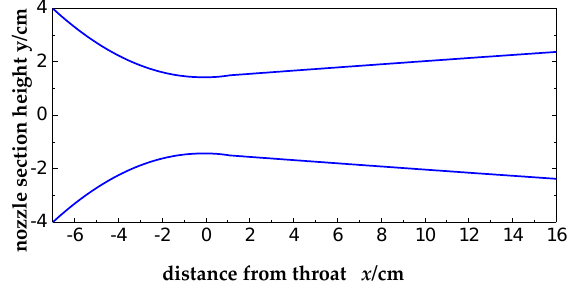
Figure 6. Geometric data of the de Laval nozzle.